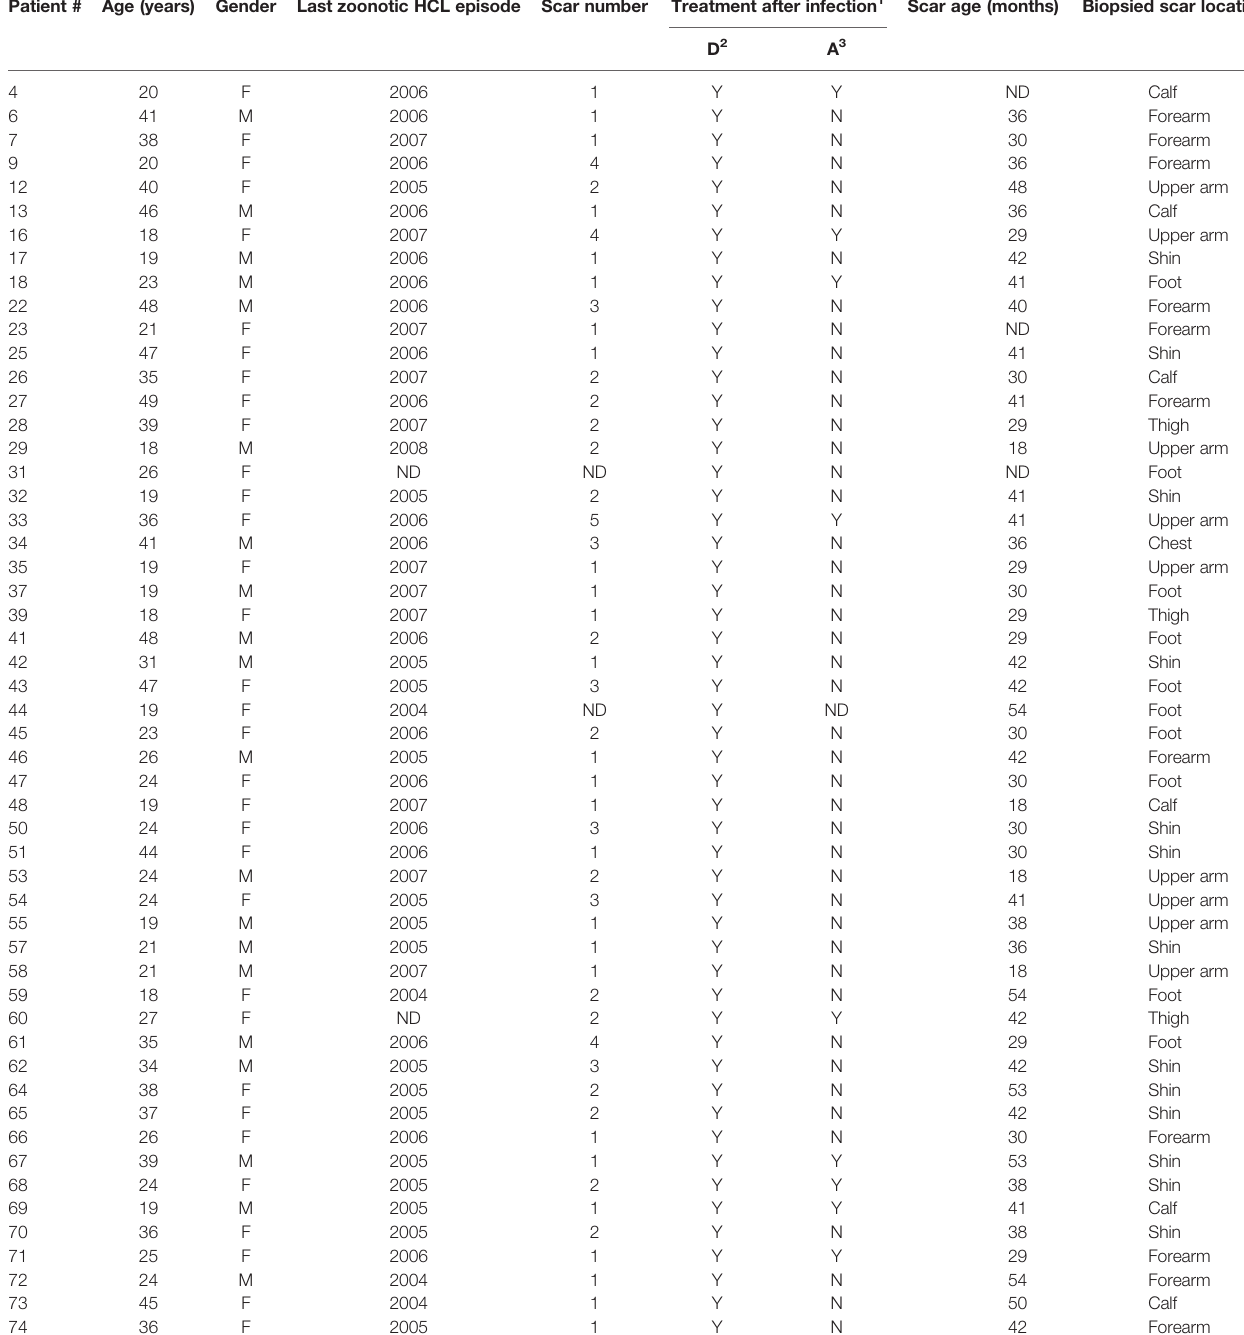
TABLE 1 | Demographic characteristics and disease history of 53 healthy volunteers clinically cured of Human Cutaneous Leishmaniasis due to L. major who are included in the present